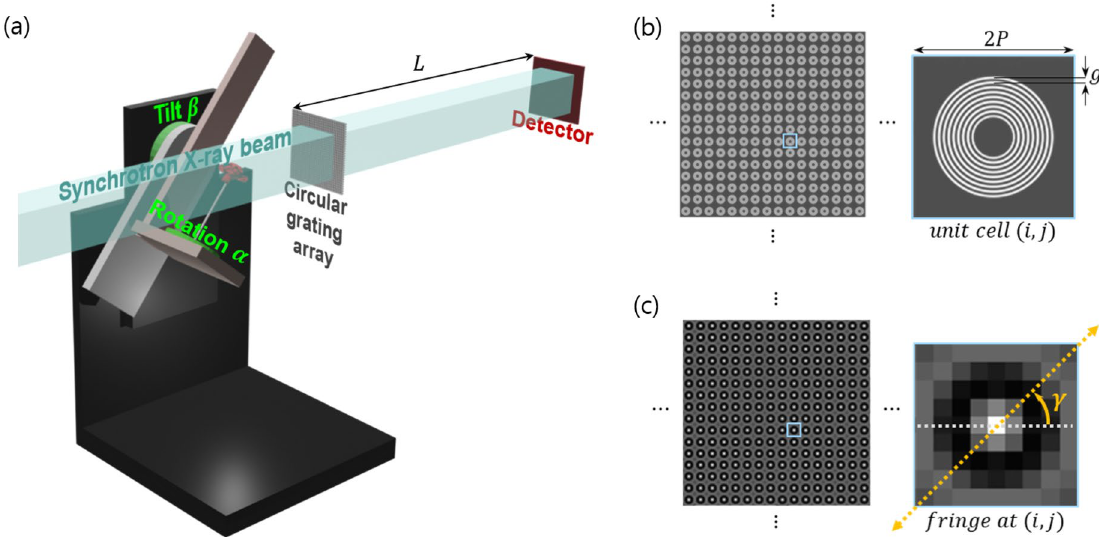
Figure 1. Experimental setup for X-ray scattering tensor tomography with circular gratings. An overview of the setup is shown in ( a ). The rotation motor revolves α degrees and the rotation axis can be tilted β degrees. The circular grating array ( b ) is composed of unit cells where P is half the unit cell size and g is the period of the fine grating lines. It is placed near the sample at a distance L = Pg / 2 (cid:31) from the detector. A circular fringe ( c ) is formed at the detector where the 2D directional scattering signal is extracted by measuring the visibility reduction along the radial profile at an angle − 90 ◦ ≤ γ < 90 ◦